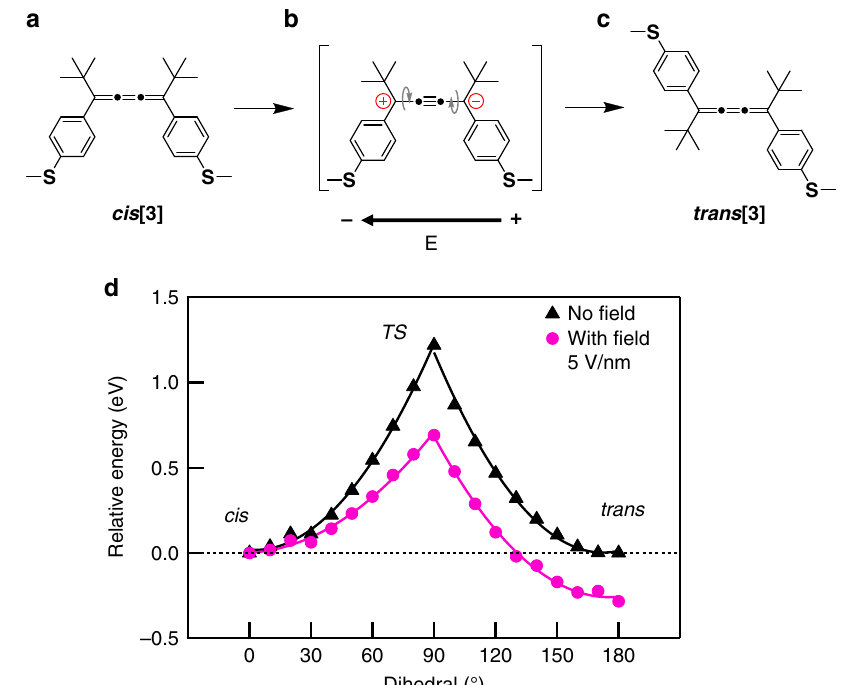
Fig. 4 Calculated reaction energy with and without fi eld. a Standard canonical resonance structure and b zwitterionic resonance structure of cis[3] . c Standard canonical resonance structure of trans[3] . Gray arrows illustrate the rotation along the C – C bonds. d Relative energy calculated without (black) and with an electric fi eld of 5 V/nm (magenta). Note that the curves are offset vertically to set the energy of cis to